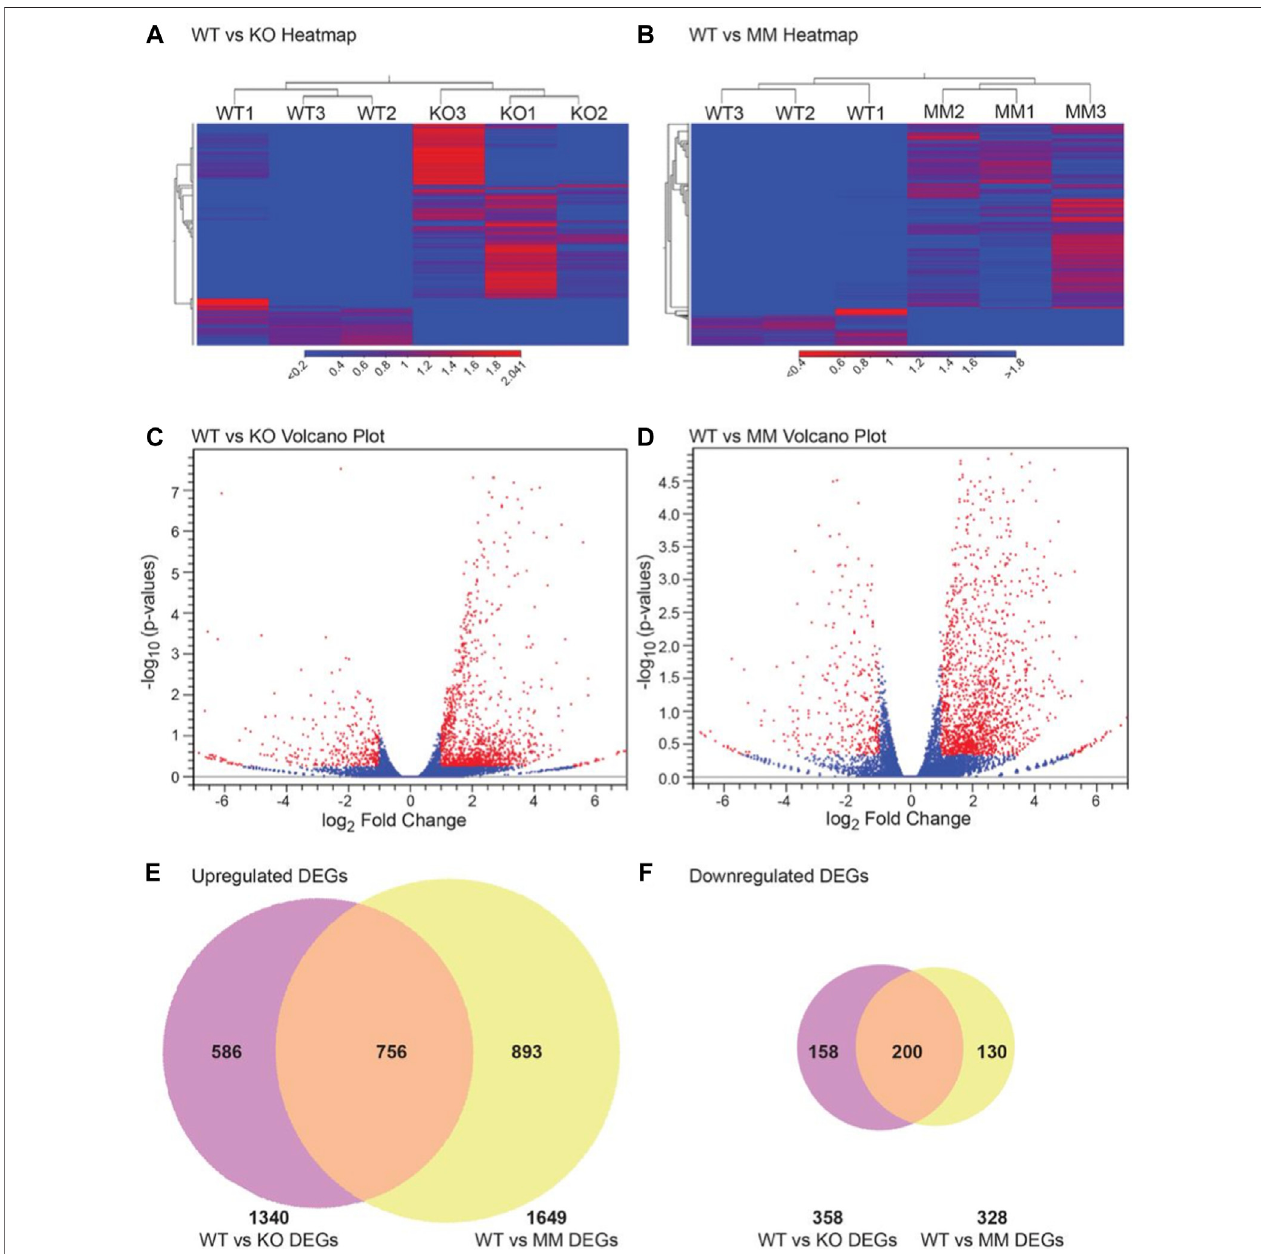
FIGURE 3 | DEGs in Dot1L -KO and Dot1L -MM ESREs. Analyses of HPC transcriptomes were performed in wildtype (WT), Dot1L -KO, and Dot1L -MM ESREs on the 3rd day of ex vivo culture. RNA-seq libraries were prepared using 500 ng of total RNA extracted from pooled ESRE cells and sequencing was performed on an Illumina NovaSeq 6000 platform. RNA-seq data were analyzed using the CLC Genomics Workbench. All expressed genes were distributed according to TPM values. Hierarchical clustering was performed on differentially expressed genes (absolute fold change ≥ 2, p value ≤ 0.05) in WT versus Dot1L -KO groups (A) , and WT versus Dot1L -MM groups (B). The DEGs in the Dot1L -KO, and Dot1L -MM ESRE cells are presented in Volcano plots [ (C,D) respectively], with red dots showing the differentially expressed genes ( n = 3/genotype). Finally, Venn diagrams showing that majority of the DEGs (~82%) in either Dot1L -KO or Dot1L - MM are upregulated (E,F) . Venn diagrams also showed that about 35 – 40% of the DEGs were unique to either Dot1L -mutant group (E,F) .